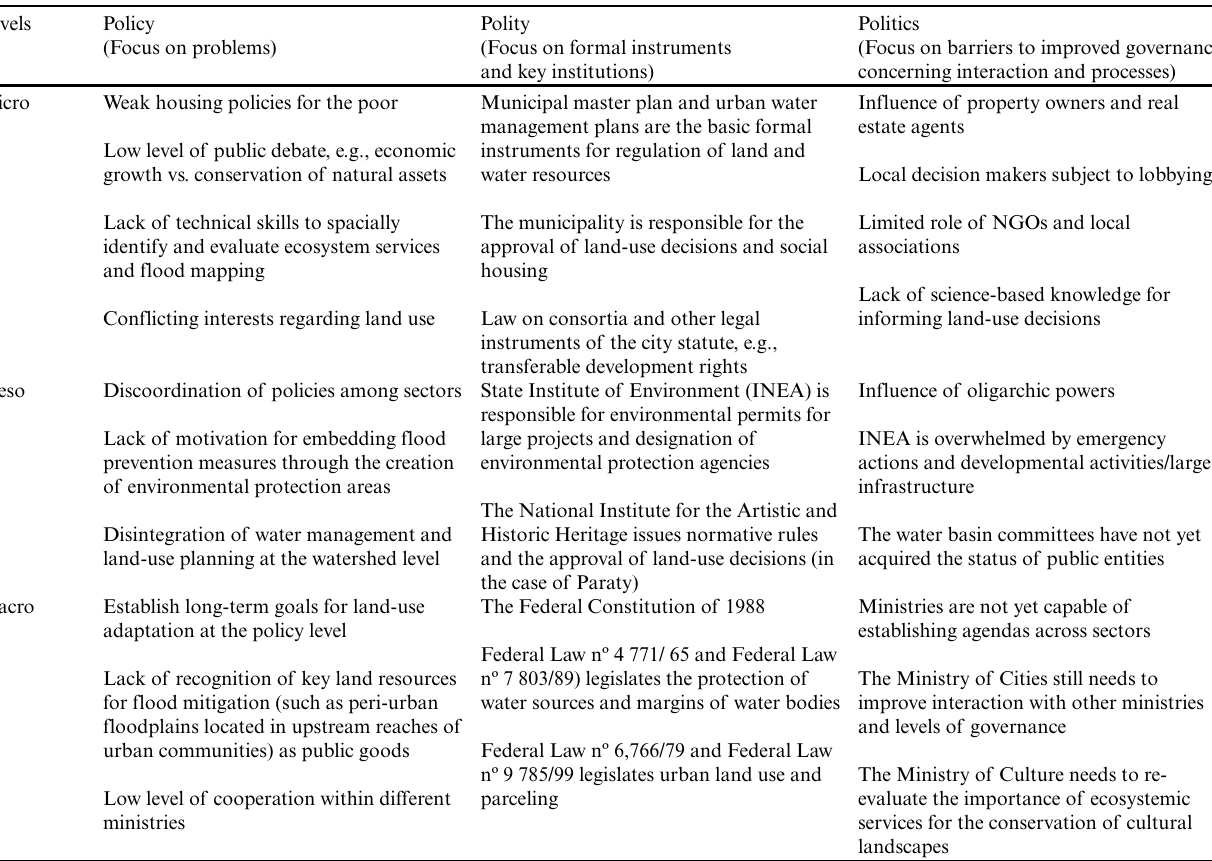
Table 1 . Heuristic framework for analyzing political dimensions of land-use change in Paraty, Brazil (adapted from Voß and Bornemann 2011).